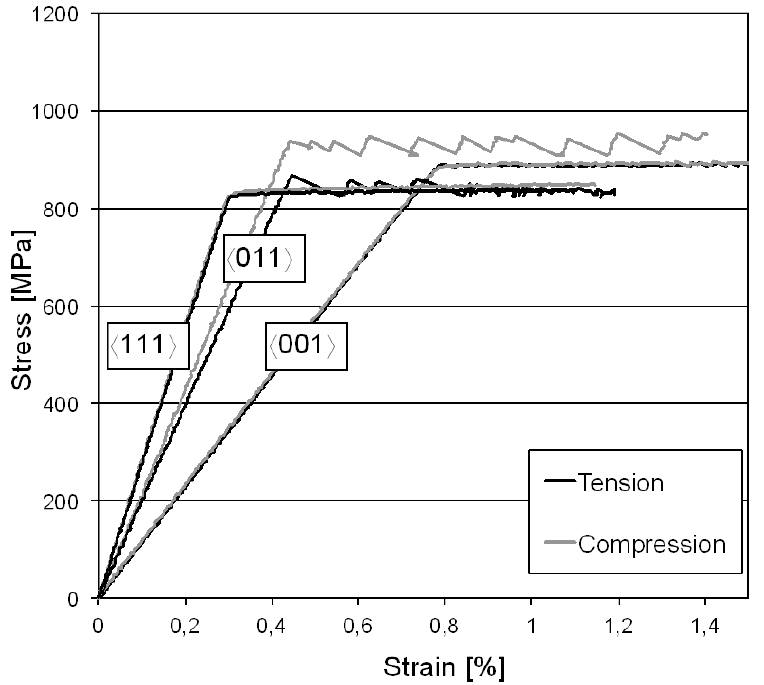
, and 〈 001 〉 〈 011 〉 〈 111 〉